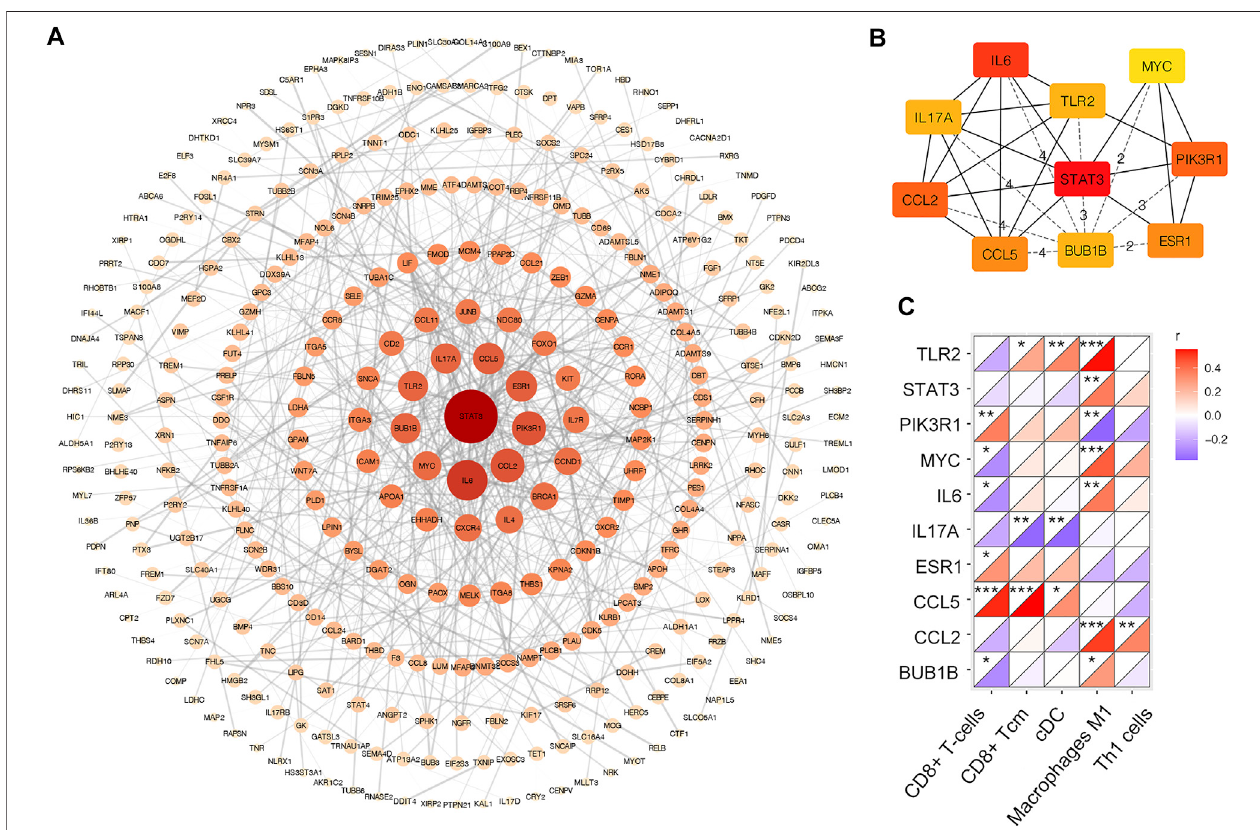
FIGURE 6 | PPI network of DEGs in merged dataset (A) PPI network of DEGs. The color depth and shape size of the dots are positively correlated with degree (B) Top 10 hub genes in the network (C) Correlation matrix of xCell scoresof signi fi cantly changed immunecell subtype with top 10 hub genes. * p < 0.05, ** p < 0.01, *** p < 0.001.